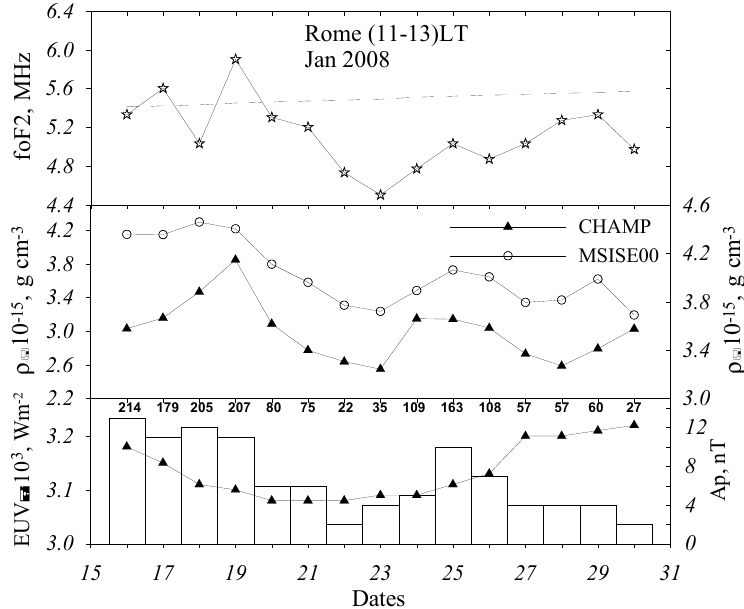
Figure 6. Same as Figure 3 but for the January 2008 SSW event. Ionospheric observations at Rome in January 2008 were developed with the method described in [24] to retrieve aeronomic parameters responsible for the observed N m F 2 var- iations. The extracted parameters along with observed N m F 2 neutral gas density, and ge- omagnetic indices are given in Figure 7. MSISE00 model atomic oxygen and exospheric temperature variations are given for the further discussion. Both versions of our method give [O] 300 variations similar to the MSISE00 model ones with the minimum on 22–23 Jan- uary following Ap index variations. However, a comparison of 16–17 January to 22–23 January gives a difference of ~49% for the retrieved [O] variations, and only a 16% differ- ence for MSISE00 variations. We remind the reader that MSISE00 is driven by solar and geomagnetic activity indices. This means that the [O] 300 depression around 22–23 January is only partly due to geomagnetic activity variations, while the main contribution is re- lated to the SSW impact.